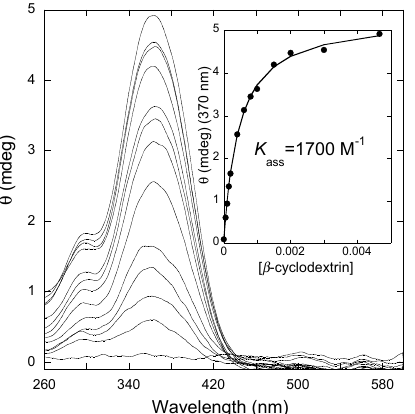
Figure 10. ( a ) Spectral variations upon irradiation at 366 nm of dracoflavylium (2 × 10 − 5 M) at pH = 4.1; ( b ) the same at pH = 3.1 in the presence of the HCD (1.6 × 10 − 2 M) illustrating the higher photochromic contrast Figure 11. Circular dichroism spectra of the compound 4 ′ -(2-hydroxyethoxy)-7-Hydroxyflavylium in Figure 11. Circular dichroism spectra of the compound 4 (cid:48) -(2-hydroxyethoxy)-7-Hydroxyflavylium in observed in the presence of the host molecule. With permission from RSC, reference [30]. the presence of increasing concentrations of β - cyclodextrin at pH = 4.8 . With permission from Elsevier, the presence of increasing concentrations of β -cyclodextrin at pH = 4.8. With permission from Elsevier, reference [31]. reference [31].